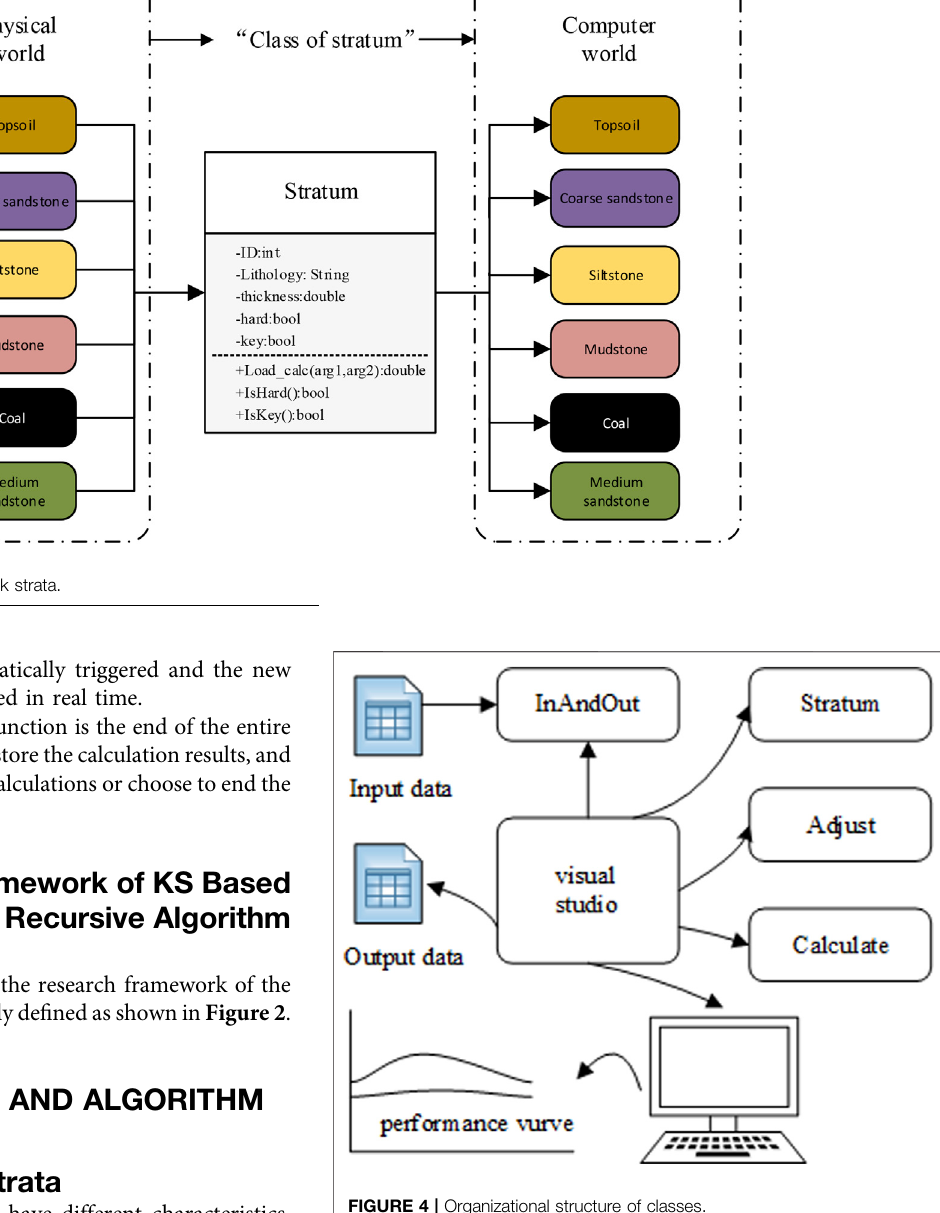
FIGURE 4 | Organizational structure of